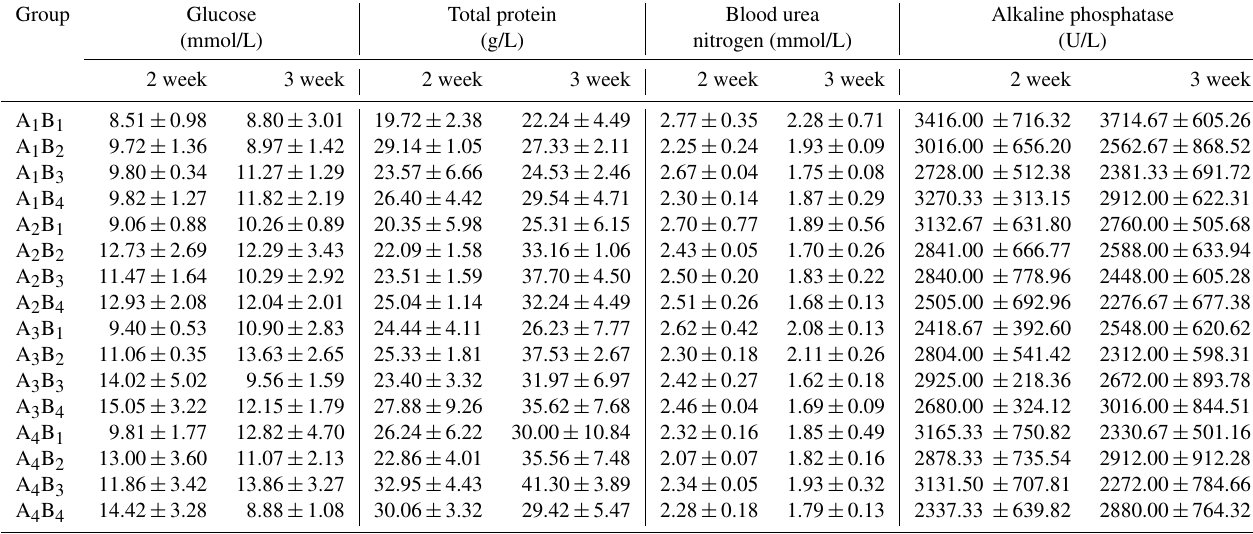
Table 6. The plasma parameters of Arbor Acres broilers under low temperature conditions supplemented by glutamine and L-carnitine. Group Glucose Total protein Blood urea Alkaline phosphatase